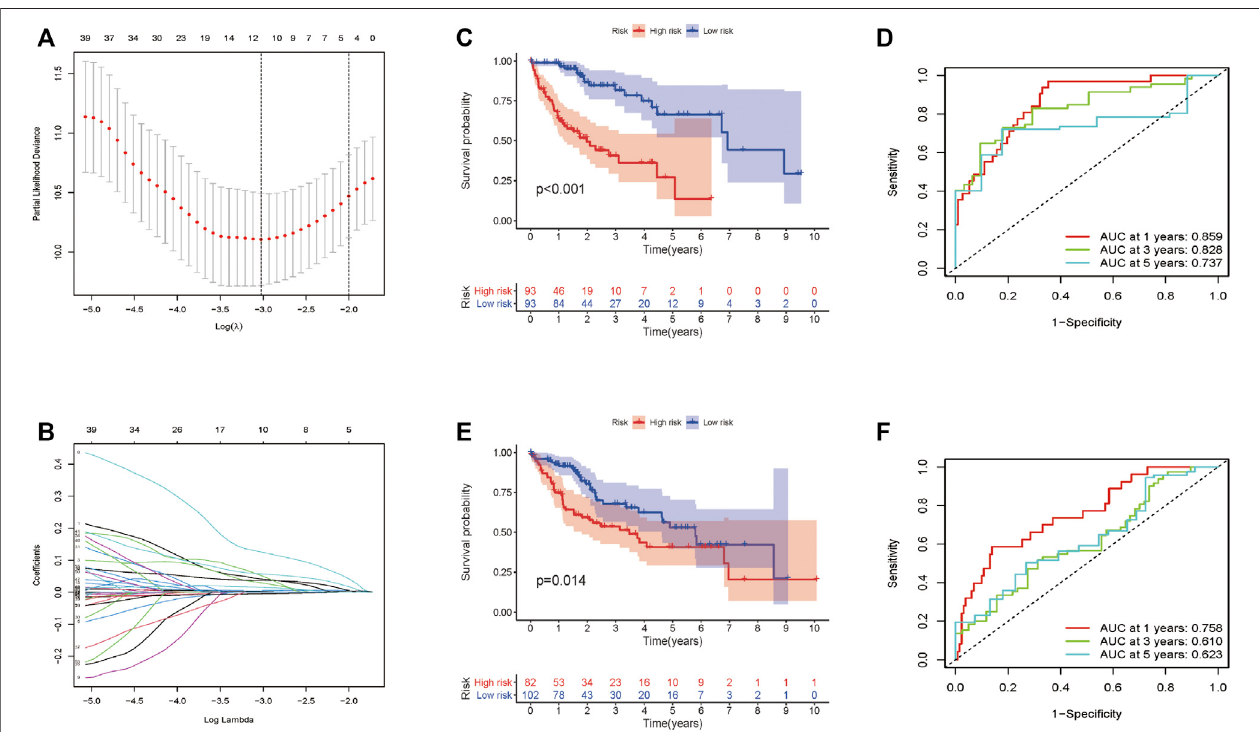
FIGURE5| Constructionandvalidation oftheprognosticsignatureforHCCpatients. (A – B) LassoCoxregressionidenti fi ed10prognosticgenes.Survivalanalysis results in the training cohort (C) and the validation cohort (E) . ROC curve showing the prediction accuracy of the prognostic signature in the training cohort (D) and the validation cohort (F)